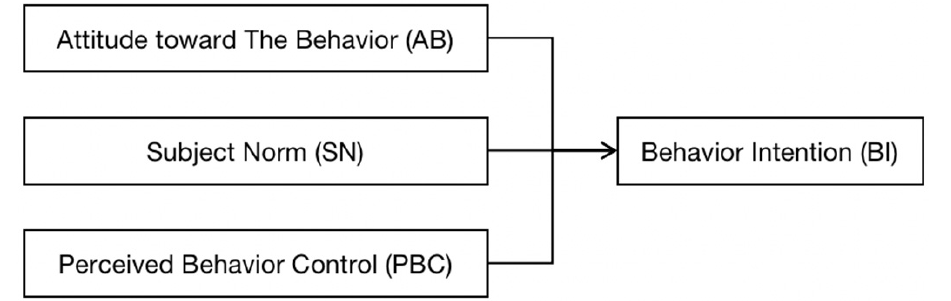
Figure 1. Framework of employees’ planned behavior.